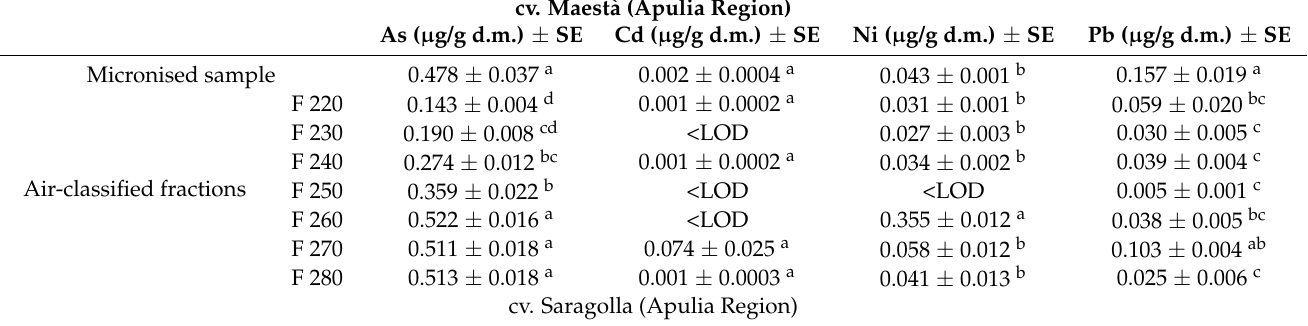
Table 1. Group I: average values ± standard error (SE) of arsenic (As), cadmium (Cd), nickel (Ni), and lead (Pb) contents in the micronised samples and F-type air-classified fractions; d.m.: dry matter; LOD: limit of detection. Different letters indicate significant difference (p < 0.05 ), n = 3. cv. Maestà (Apulia Region) As ( µ g/g d.m.) ± SE Cd ( µ g/g d.m.) ±